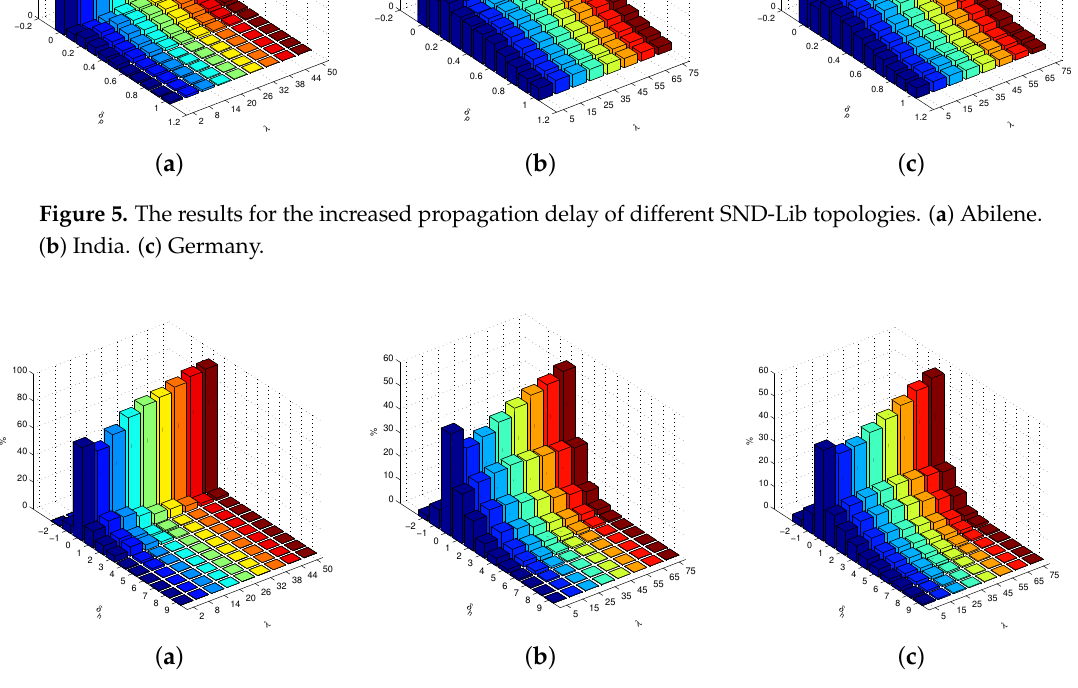
Figure 6. The results for the increased number of hops of different SND-Lib topologies. ( a ) Abilene. ( b ) India. ( c )